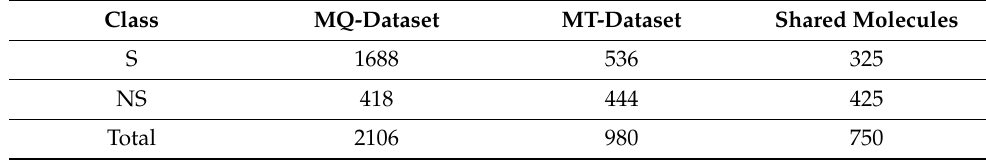
Table 3. Datasets